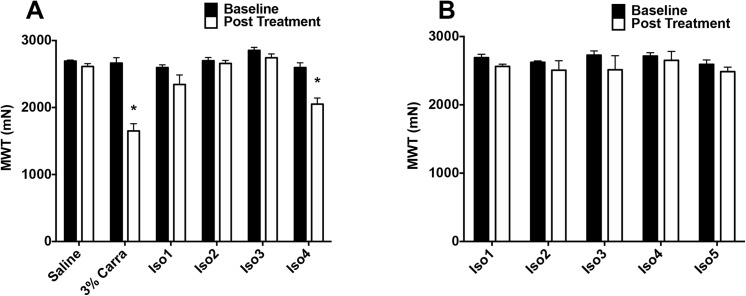
Combination of ATP (A) or αβ–meATP (B) with Lactate and Protons.Muscle withdrawal thresholds were assessed before and 30 min after intramuscular injection. (A) Protons, lactate, and ATP were given in combination across series dilutions. Combining protons, lactate, and ATP had a significant effect on muscle withdrawal (Repeated measures ANOVA F5,27 = 17.986, p < 0.001), but only the most dilute combination (C4) was decreased relative to saline controls (Tukey test, p = 0.001). The positive control, intramuscular injection of 3% carrageenan shows a significant decrease 24h after injection (p<0.001). (B) Protons, lactate, and α,β–meATP were given in combination across a series of dilutions. None of combinations tested produced significant decreases in muscle withdrawal threshold (Repeated-measures ANOVA F3,14 = 5.373, p < 0.011). *, p < 0.05.